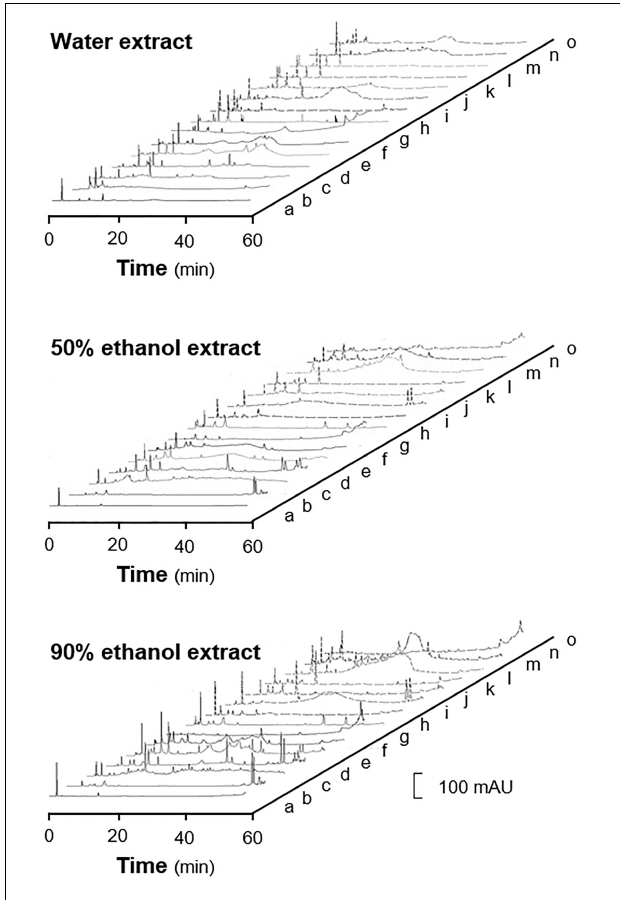
FIGURE 2 | HPLC profiles of herbal extracts from the 15 collected herbs. The fingerprints were obtained with an Agilent HPLC 1200 series system (Agilent, Waldbronn, Germany) and a Waters Symmetry C18 column (4.5 mm × 250 mm, 5 µ m i.d.). The mobile phase was composed of acetonitrile and water, and the wavelength of UV detector was set to 254 nm with full spectral scanning from 190 to 400 nm. The extracting solvents are indicated. The extracts from 3 batches of herbs were subjected to analysis, a representative profile was shown. a, Codonopsis Radix; b,